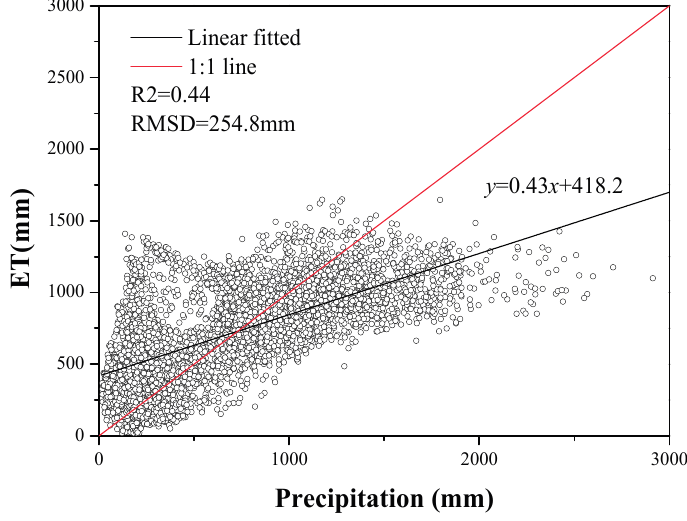
Figure 11. Scatter plot between annual precipitation and annual ET in South Asia in